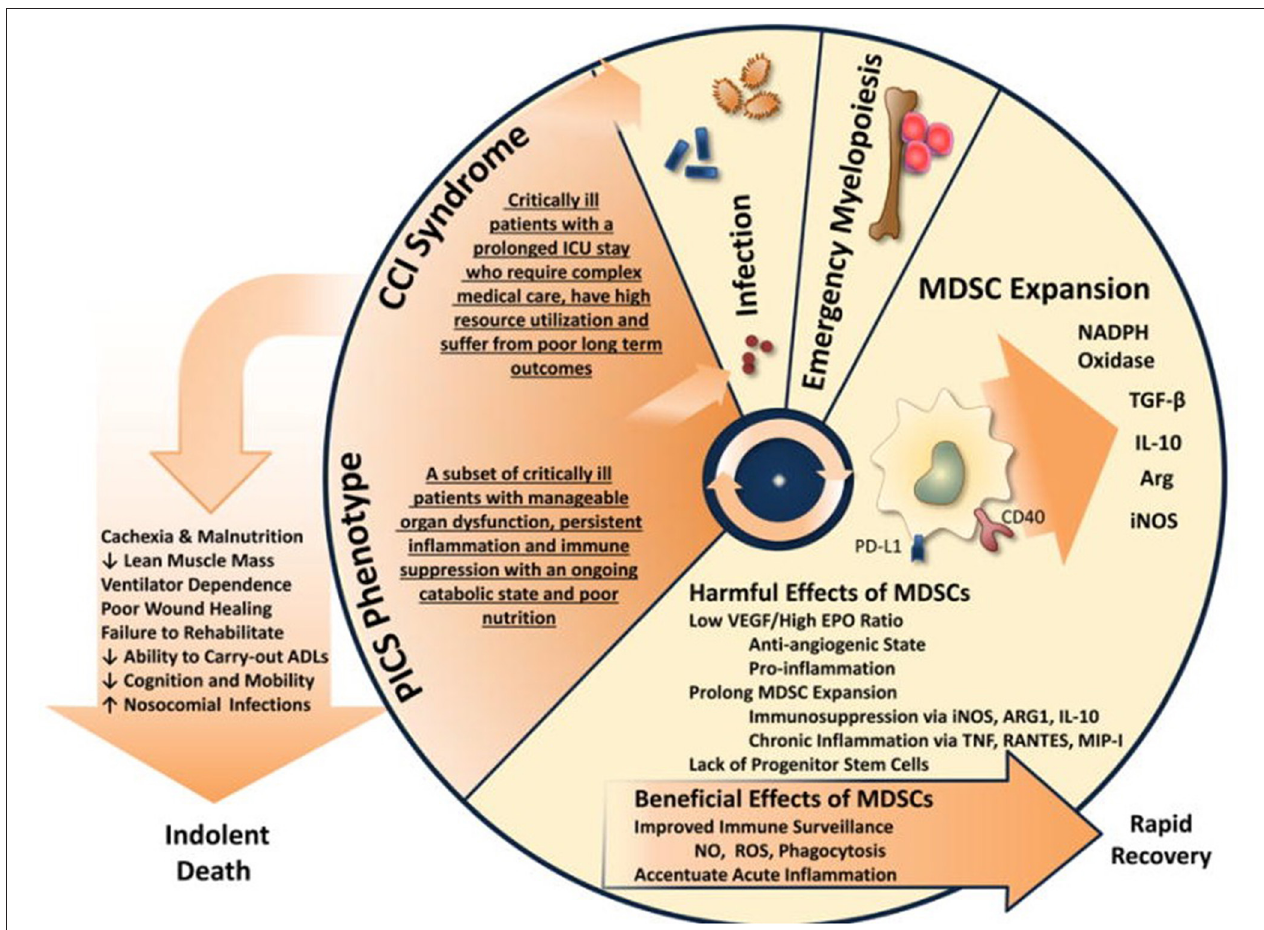
FIGURE 6 | The proposed self-perpetuating cycle by which PICS drives muscle loss and inflammation. Modified from Mira et al.